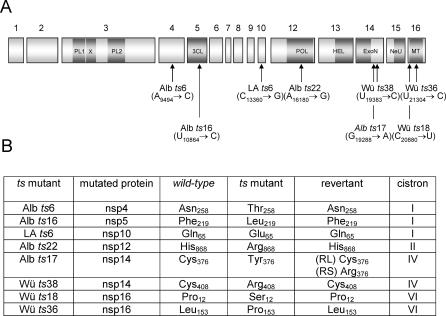
Genotypic Analysis of Selected MHV-A59 ts Mutants(A) The positions of mutations responsible for the ts phenotype of selected MHV-A59 mutants are illustrated in relation to the non-structural proteins (nsp1–16) produced by proteolytic processing of the ORF1a/ORF1b polyprotein, pp1ab. Nucleotide changes are numbered according to the sequence of the infectious cDNA clone of MHV-A59.(B) The amino acid substitutions responsible for the mutant and revertant phenotypes are listed together with the mutated protein and the cistron to which each mutant has been assigned. The amino acids are numbered from the amino-terminus to the carboxyl-terminus of each of the non-structural proteins.